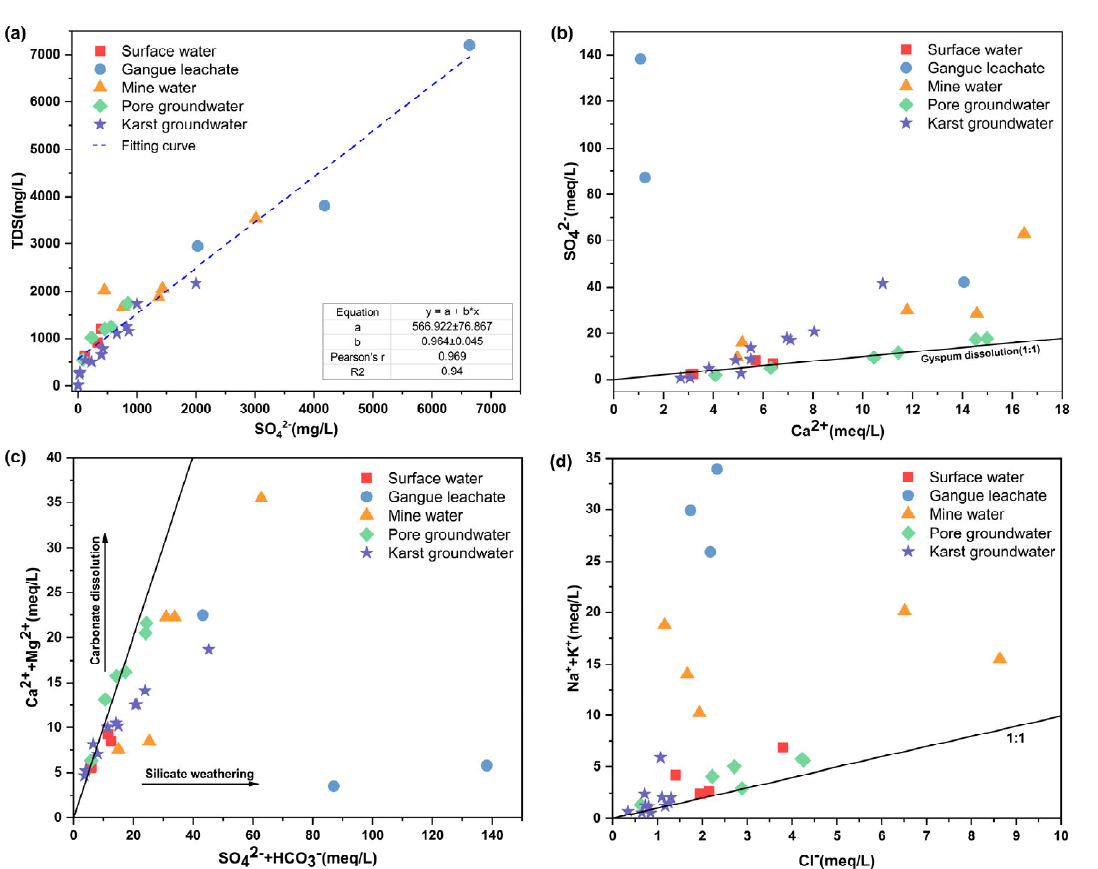
Figure 4. Ionic relationships of water samples in the study area. ( a ) TDS vs. SO 42 − ; ( b ) SO 42 − vs. Ca 2+ ; ( c ) Ca 2+ + Mg 2+ vs. SO 42 − + HCO 3 − ; ( d ) Na + + K + vs. Cl − .